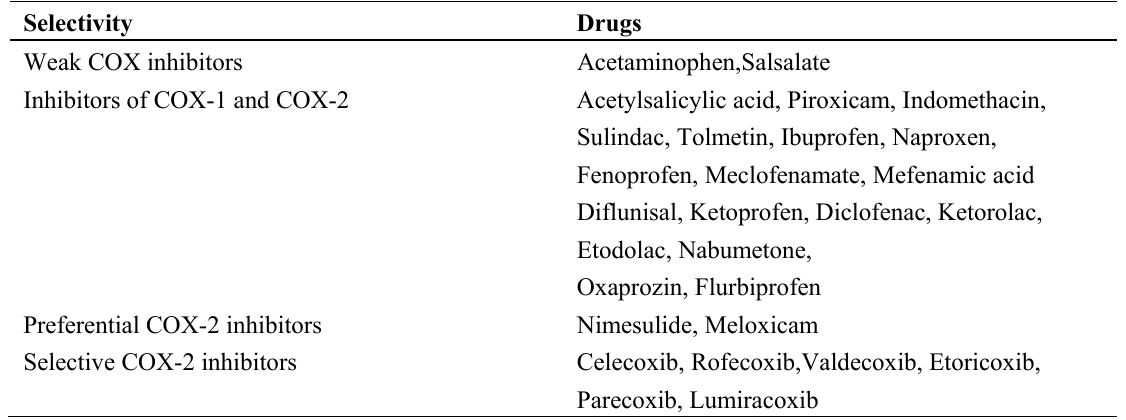
Table 1. Classification of NSAIDs according to their selectivity for COX